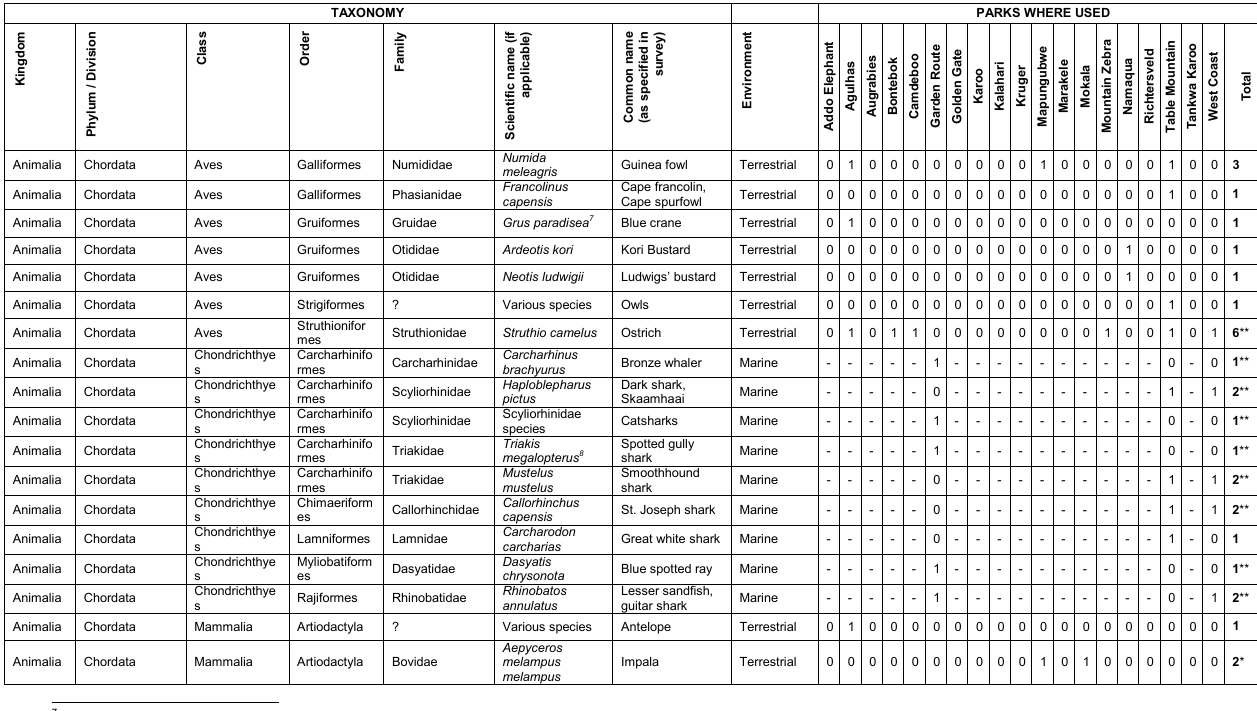
ass on m ngdo s i C l v i D i K i m / u y l P h Animalia Chordata Mammalia Artiodactyla Bovidae Alcelaphus caama 10 Red hartebeest Animalia Chordata Mammalia Artiodactyla Bovidae Antidorcas marsupialis Springbok Animalia Chordata Mammalia Artiodactyla Bovidae Connochaetes gnou Animalia Chordata Mammalia Artiodactyla Bovidae Connochaetes taurinus Blue wildebeest Animalia Chordata Mammalia Artiodactyla Bovidae Animalia Chordata Mammalia Artiodactyla Bovidae Animalia Chordata Mammalia Artiodactyla Bovidae Animalia Chordata Mammalia Artiodactyla Bovidae Hemitragus jemlahicus Himalyan thar Animalia Chordata Mammalia Artiodactyla Bovidae Hippotragus equinus Animalia Chordata Mammalia Artiodactyla Bovidae Hippotragus niger Sable Animalia Chordata Mammalia Artiodactyla Bovidae Oreotragus oreotragus Klipspringer Animalia Chordata Mammalia Artiodactyla Bovidae Oryx gazella Gemsbok Animalia Chordata Mammalia Artiodactyla Bovidae Pelea capreolus Grey rhebok Animalia Chordata Mammalia Artiodactyla Bovidae Philantomba monticola 12 Blue duiker Animalia Chordata Mammalia Artiodactyla Bovidae Raphicerus campestris Animalia Chordata Mammalia Artiodactyla Bovidae Raphicerus melanotis Grysbok Animalia Chordata Mammalia Artiodactyla Bovidae Sylvicapra grimmia Common duiker Animalia Chordata Mammalia Artiodactyla Bovidae Syncerus caffer Buffalo 11 Synonym Damaliscus dorcus phillipsi 12 Synonym Cephalophus